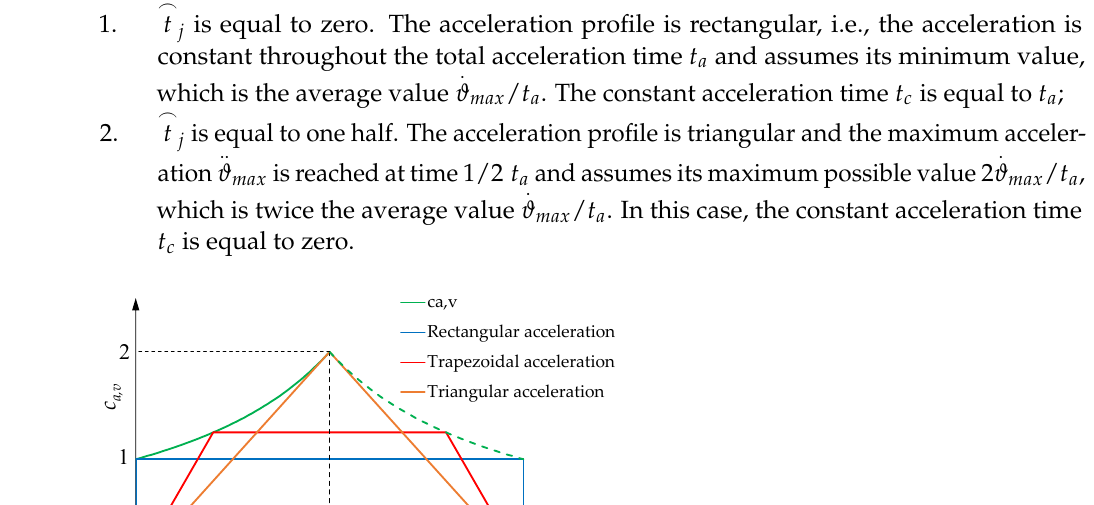
 t . In the same figure, a generic STAP is c versus j a,v